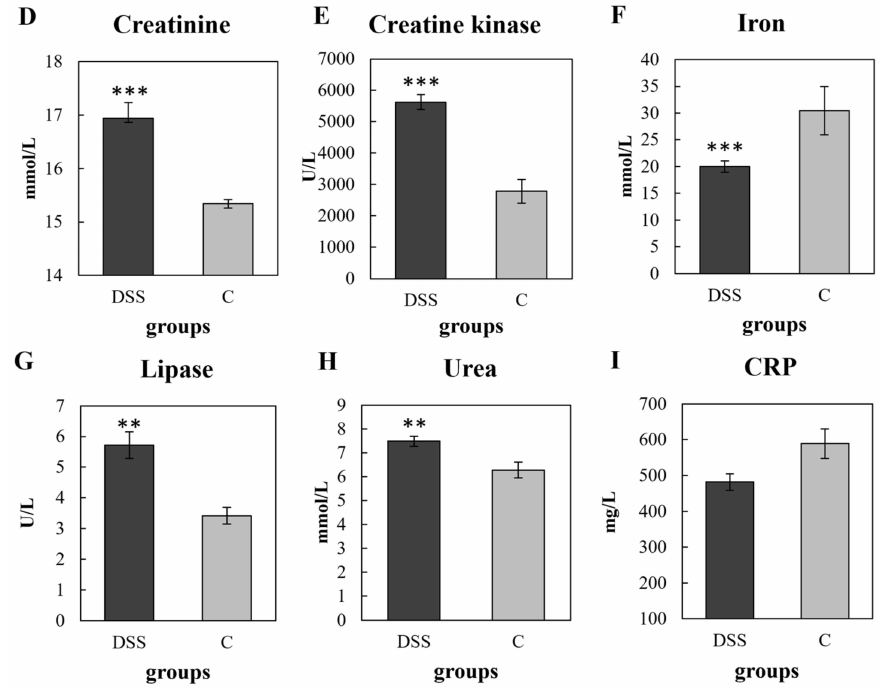
Figure 4. Serum levels of biochemical parameters in animals with DSS-induced colitis and controls. Concentration of ALP ( A ); ALT ( B ); AST ( C ); creatinine ( D ); creatine kinase ( E ); iron ( F ); lipase ( G ) urea ( H ) and CRP ( I ). Data are expressed as mean ± SEM ( n = 16/DSS group; n = 6/C group); (* p < 0.05; ** p < 0.01; *** p < 0.001). DSS, induced colitis; C, healthy control. ALP, alkaline phosphatase; ALT,